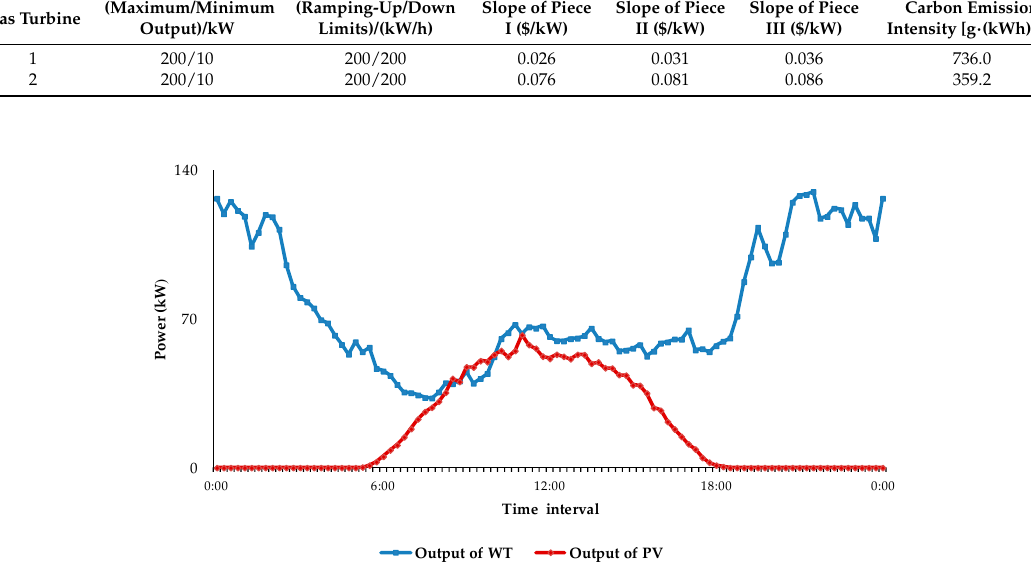
Figure A1. Daily active power output curves of the wind turbine and the PV generator.